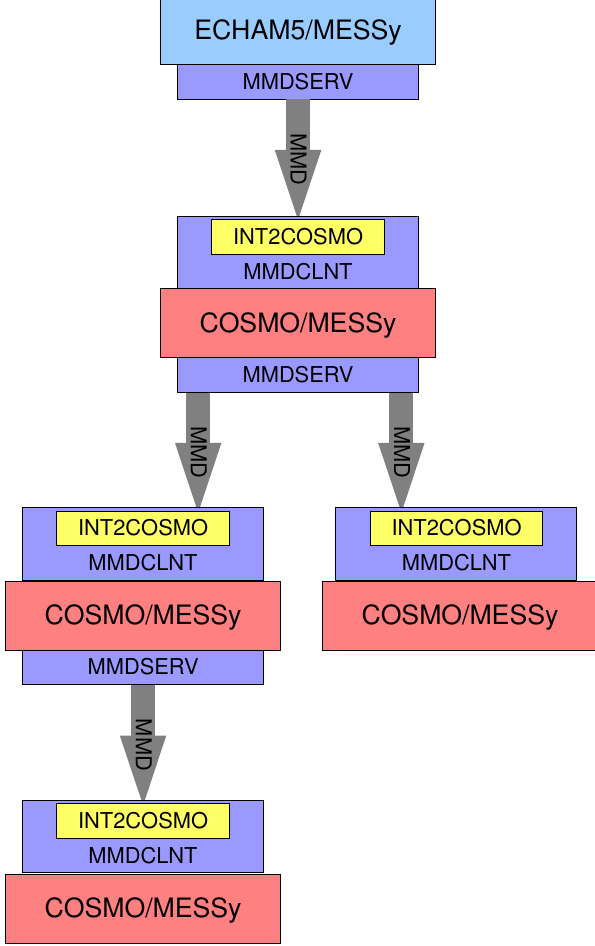
Fig. 4. Illustration of the data flow in an exemplary MECO(4) setup with ECHAM5/MESSy as master Server and four COSMO/MESSy